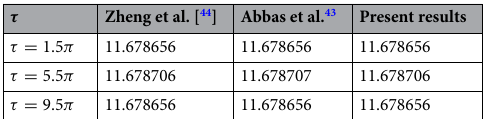
Table 1. Comparison of f yy ( 0, τ) with 12,37 by keeping S